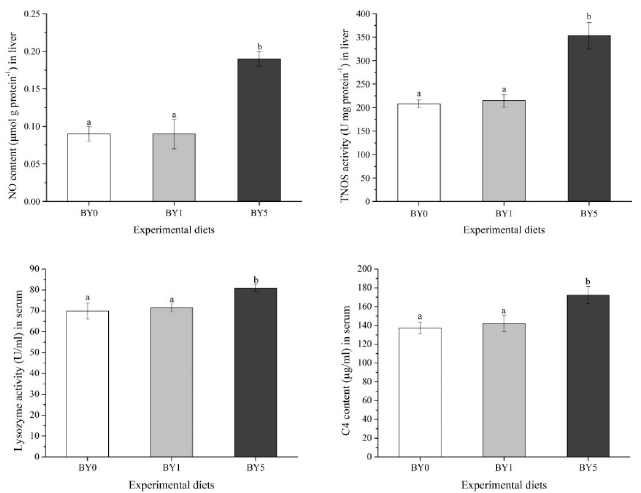
Figure 4. Immune-related parameters in liver and serum of T. ovatus fed experimental diets. Values are presented as mean ± SE ( n = 18). The small letters indicate significant differences at p < 0.05.